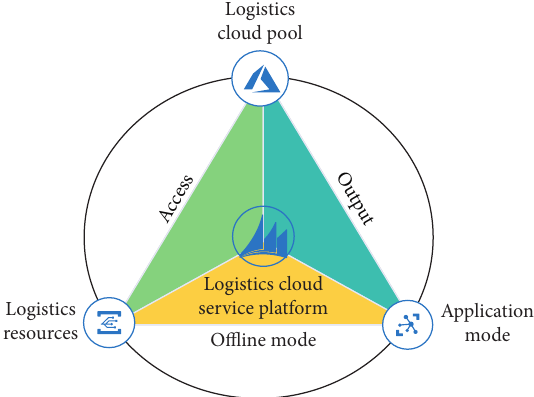
Figure 2: Analysis of the subjectivity of logistics cloud